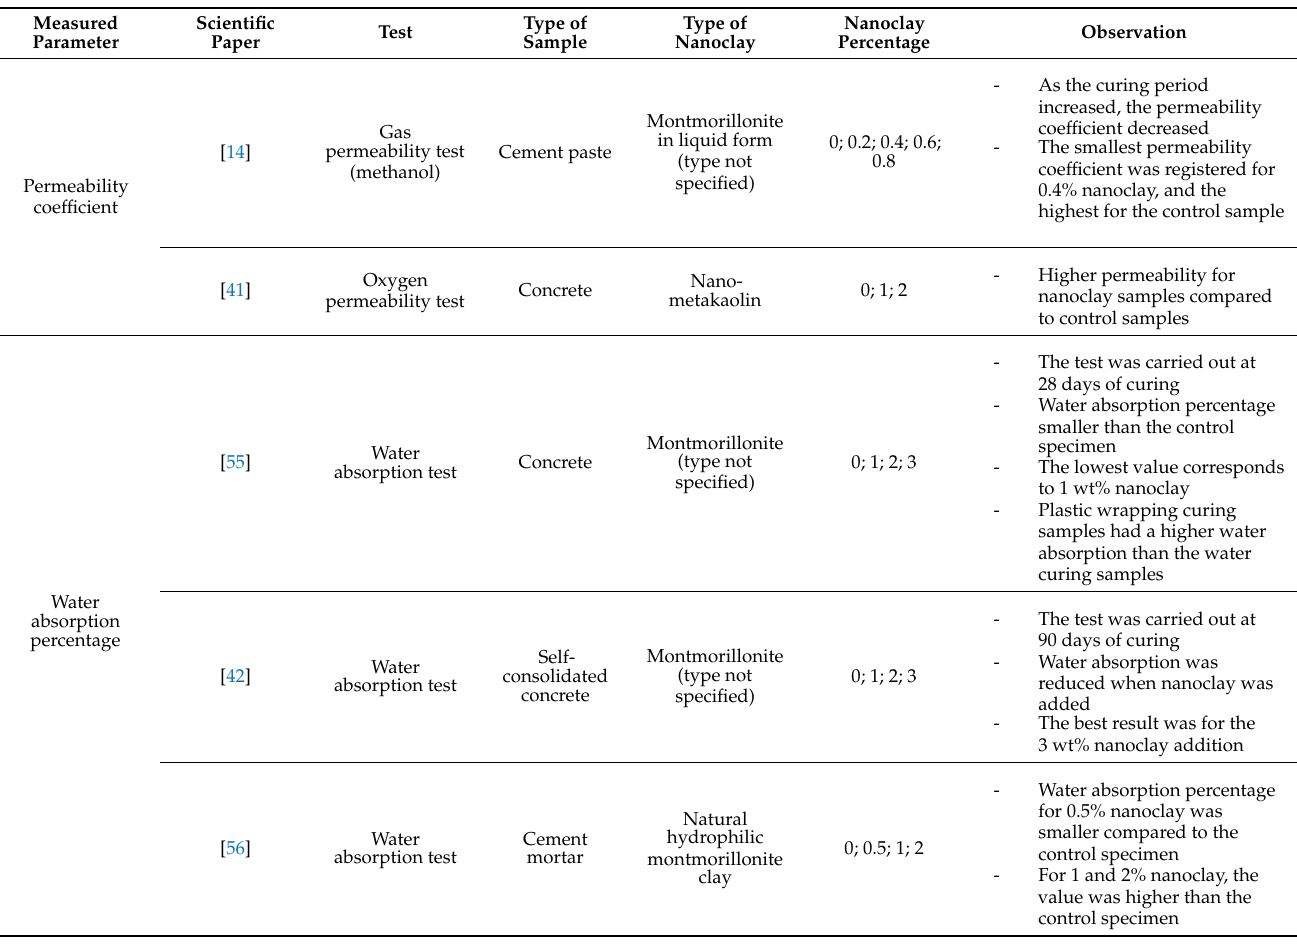
Table 5. Durability tests on nanoclay—mortar/concrete